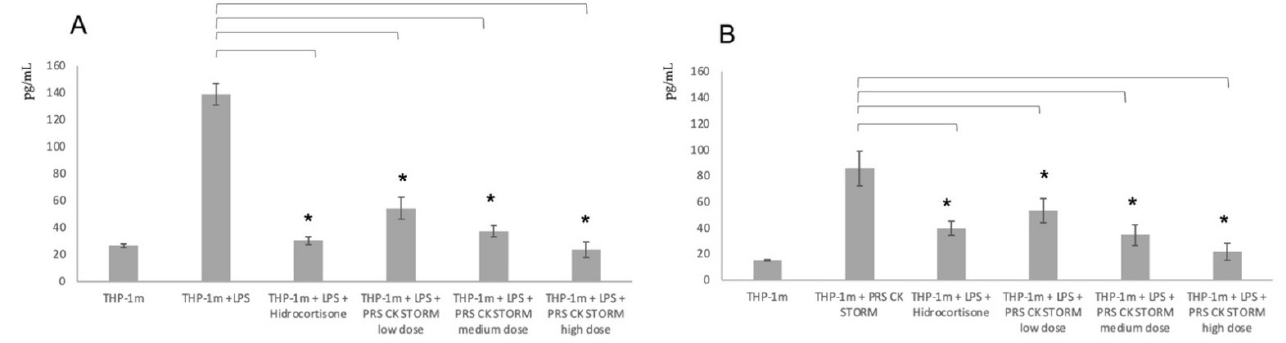
Figure 3. Release of pro-inflammatory cytokines from THP-1 cells differentiated to macrophages (THP-1m) in the in vitro model of inflammation. THP-1m were stimulated with LPS in the same way as PBMCs used in previous studies. The graphs show the pg/mL of each of the factors studied (( A ) = IL-1 β ; ( B ) = TNF- α ). Error bars correspond to the standard deviation of 3 independent experiments analyzed in duplicate. * represent a p -value < 0.05.